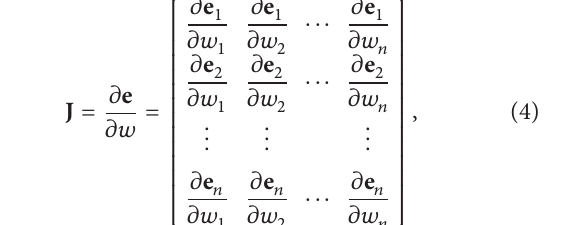
Table 3: Performance statistics of the ANN model during valida- tion.